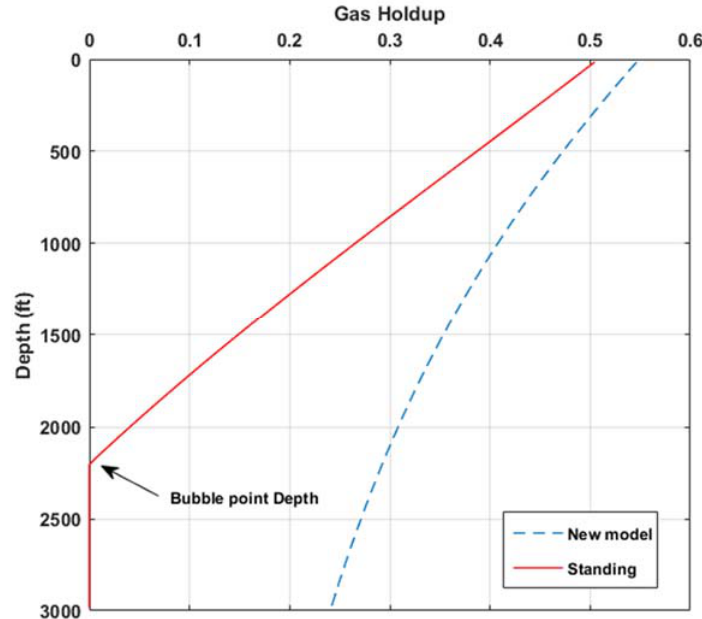
Figure 8. Gas holdup versus depth, as a function of Standing and the new correlations.